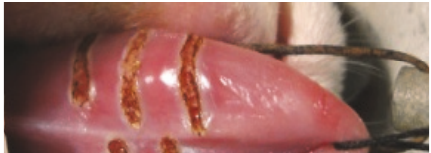
Figure 1: Induced incisions with three different wavelength diode lasers of 810, 940, and 980 nm on the ventral side of the tongue of the rabbit; from top of the tongue, 980, 940, and 810 nm laser-induced